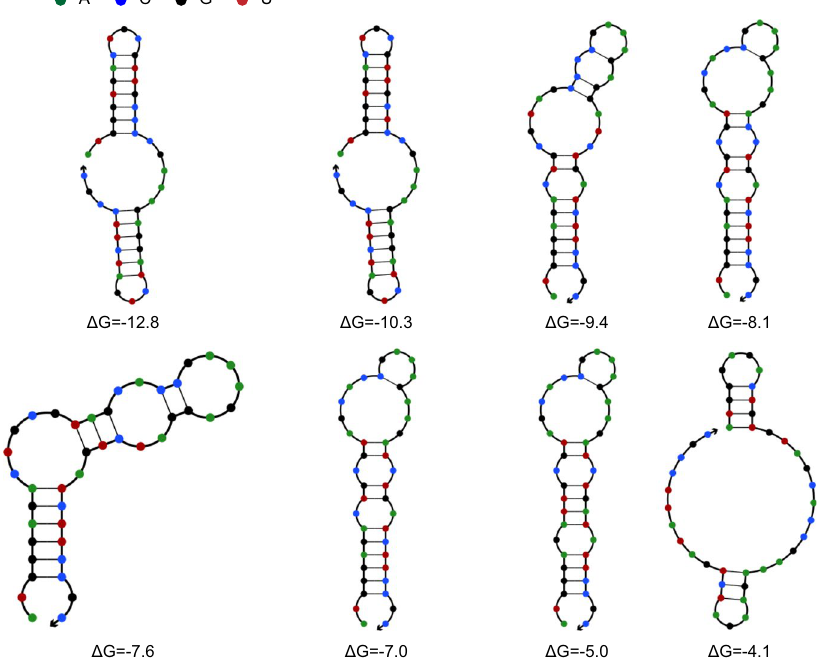
Figure 4. Predicted mRNA secondary structures of the 5 ′ region of different variant 4CL. Numbers such as − 12.8, − 10.3 meant Δ G (kcal/mol) for the 5 ′ region of mRNA secondary structure. The figure exhibited the secondary structure of the region ranged from nt + 1 to + 42. Δ G of original 4CL was − 12.8